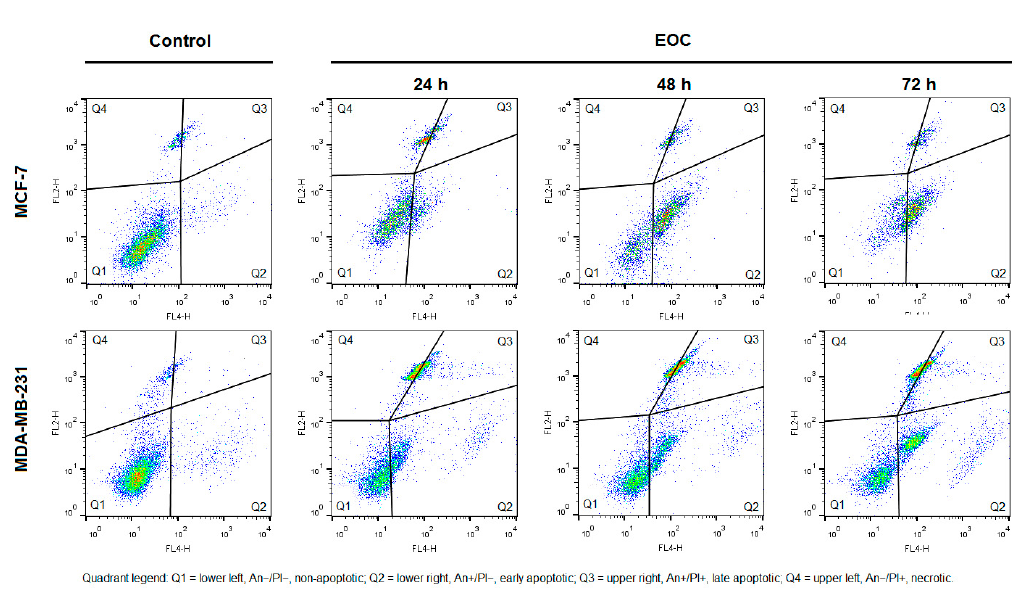
Figure 12. Effect of EOC treatment (1:25,000, 1:65,000) on: A ) caspase-7 (MCF-7), B ) caspase-3 activation (MDA-MB-231) and PARP cleavage in both cell lines ( C , MCF-7 cells; D , MDA-MB-231 cells) analyzed by flow cytometry. Data were obtained from three independent experiments and significant differences were marked as p < 0.05 (*), p < 0.01 (**), p < 0.001 (***) vs. control cells (untreated).